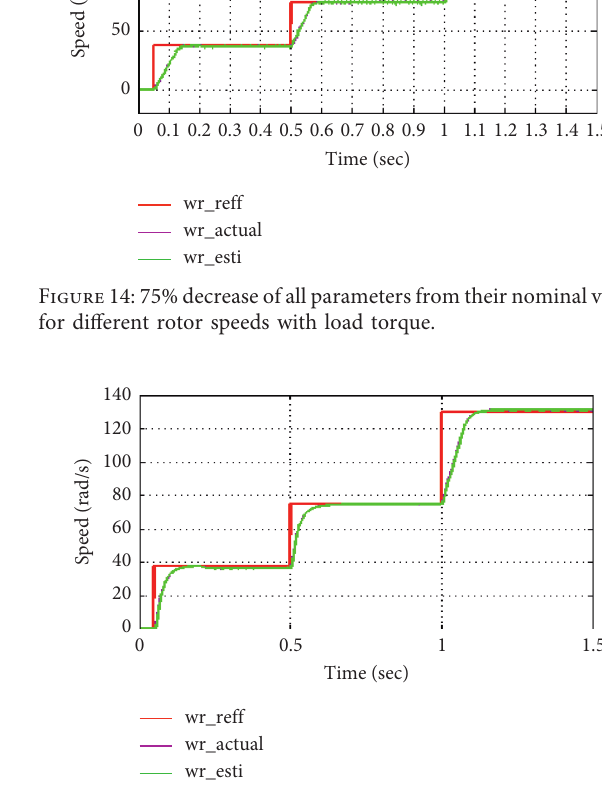
s from its nominal value for different